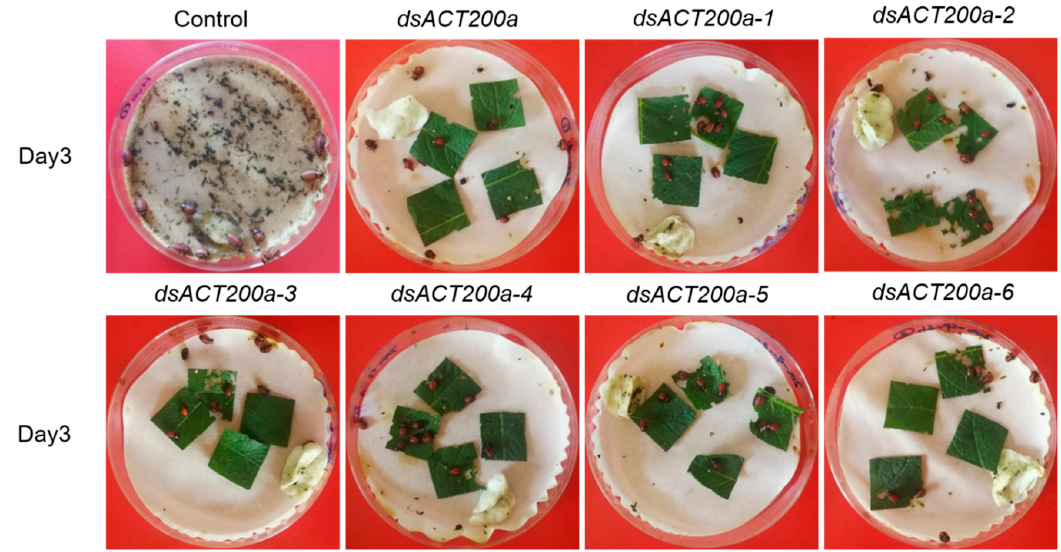
Figure 3. Leaves painted by H 2 O and ds ACT200a and its mutations were fed to third-instar CPB after 3 days.